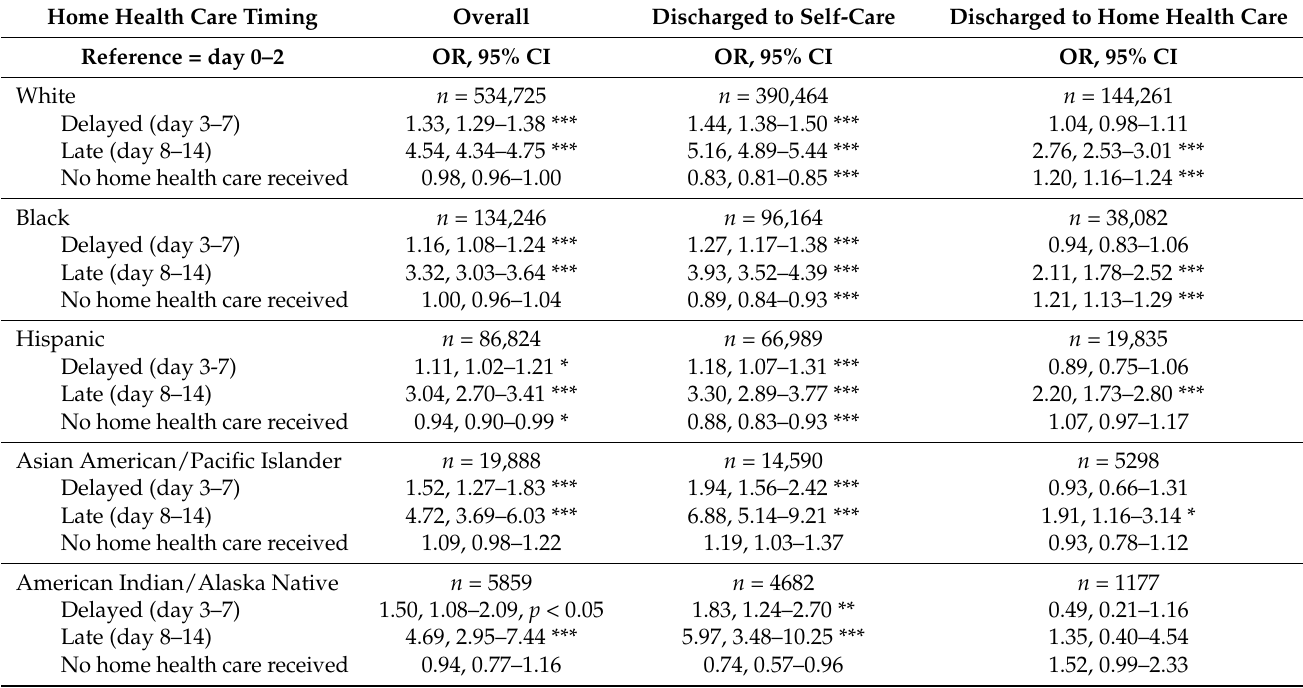
Table 3. Results of weighted logistic regression predicting 30-day all-cause rehospitalization stratified by race/ethnicity and discharge